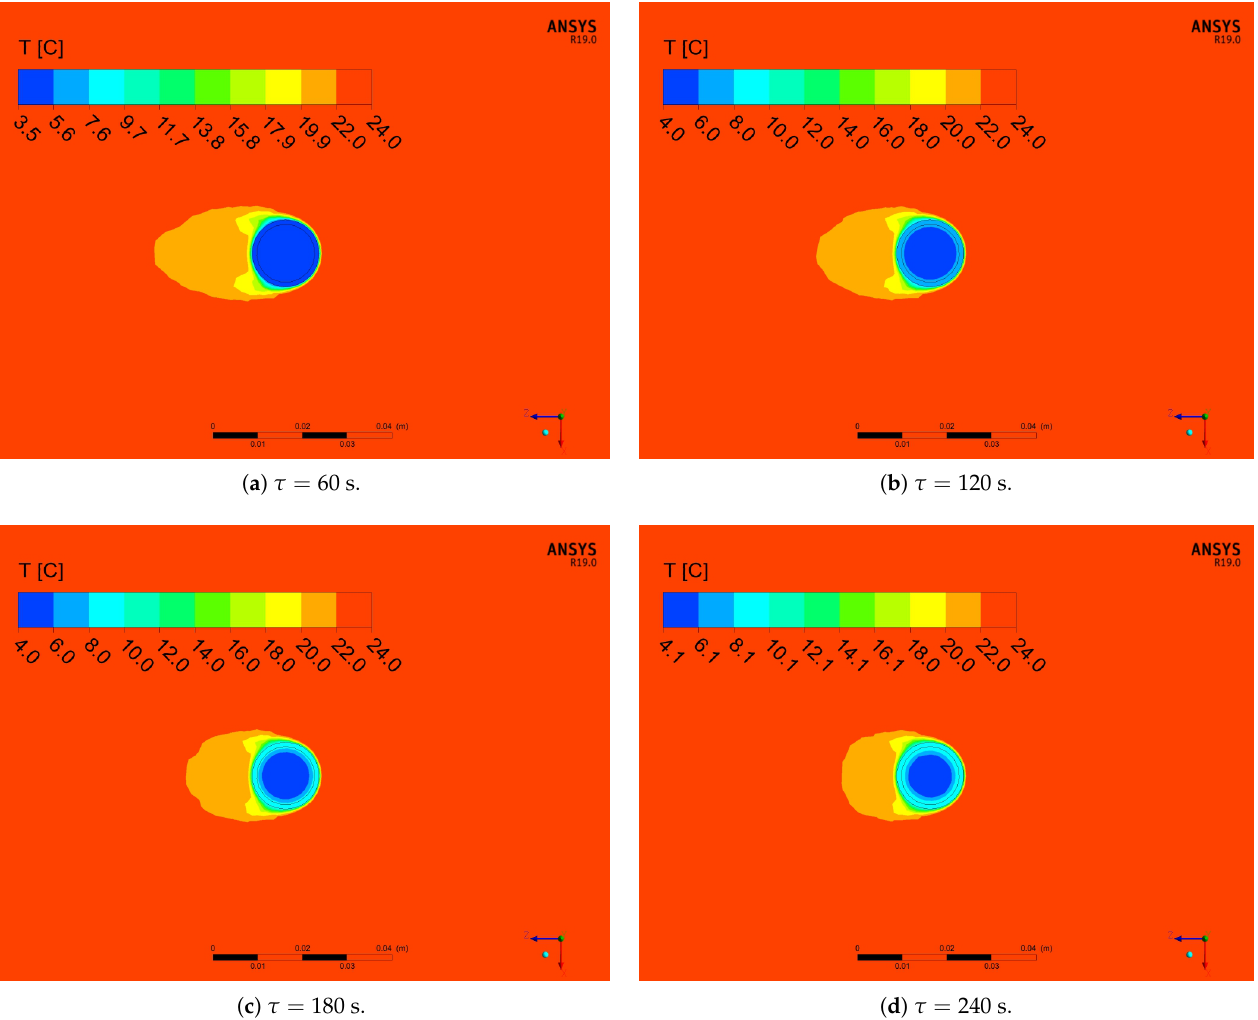
Figure 18. Numerical results of temperature distribution in the middle horizontal plane for the inlet velocity of 0.92 m/s and cylinder diameter of 15 mm and different times of the